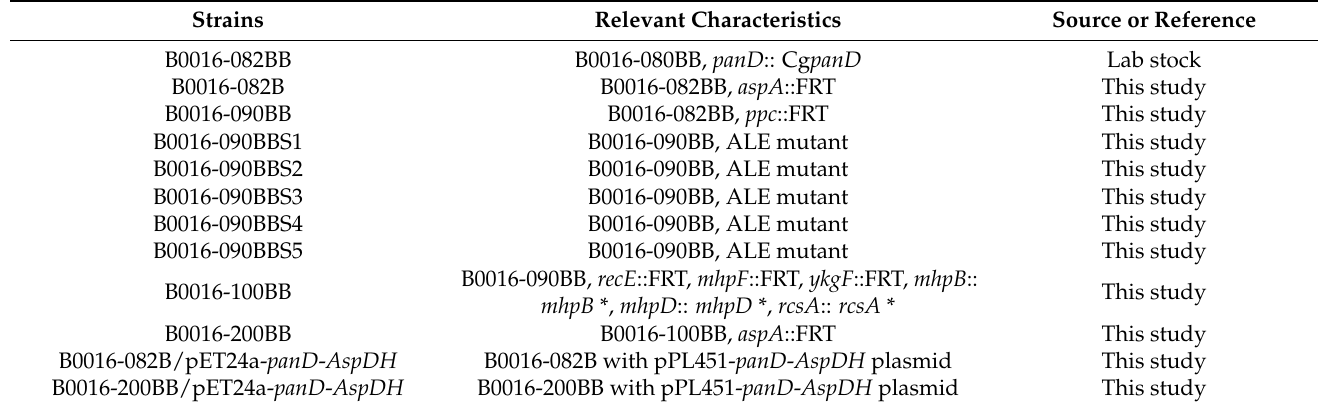
Table 1. E. coli strains and plasmids used in this